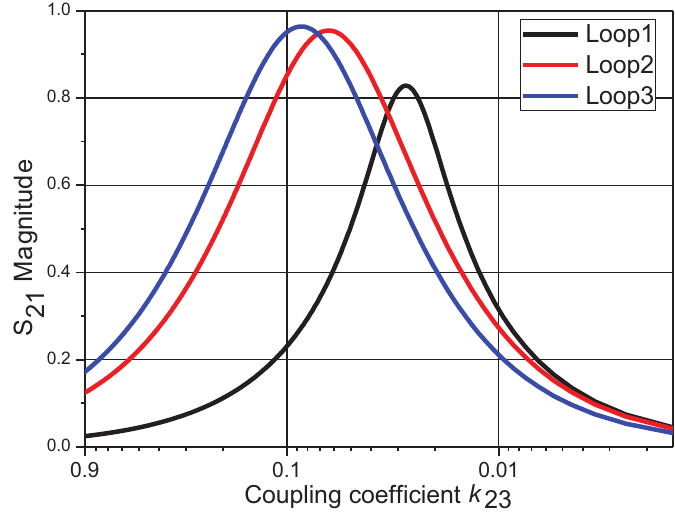
Figure 8. Simulated S 21 magnitude for different loops with varying k 23 in the Case 2